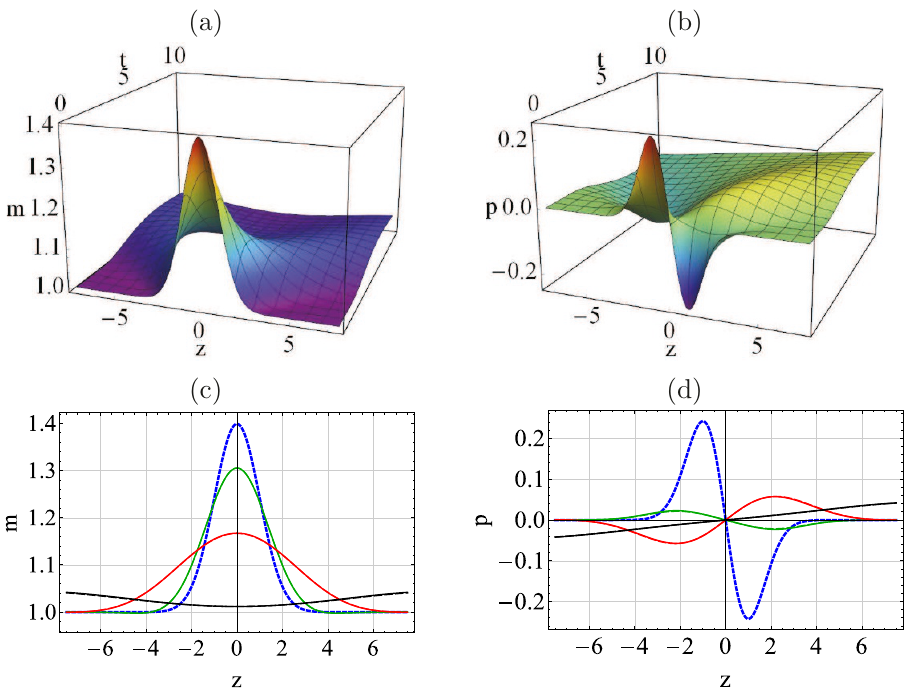
Figure 4 . Three-dimensional plots of (a) 1 + m 1 ( t, z ) and (b) p 1 ( t, z ), given by eq. (3.12) with β = b = 1 , z 0 = 0. The comparison between first-order solution (c) 1 + m 1 ( t, z ) (resp. (d) p 1 ( t, z )) and full solution m ( t, z ) (resp. p ( t, z )) obtained by solving eqs. (2.1) and (3.1) numerically. Snapshots of (c) 1 + m 1 ( t, z ) and (d) p 1 ( t, z ) at t = 0 (blue-dashed), t = 0 . 67 (green-solid), t = 2 . 0 (red-solid), and t = 10 (black-solid). Non-perturbative solutions obtained by solving eqs. (2.1) and (3.1) numerically are drawn by (green, red, and black) dashed curves too, but can be hardly distinguished from the first-order